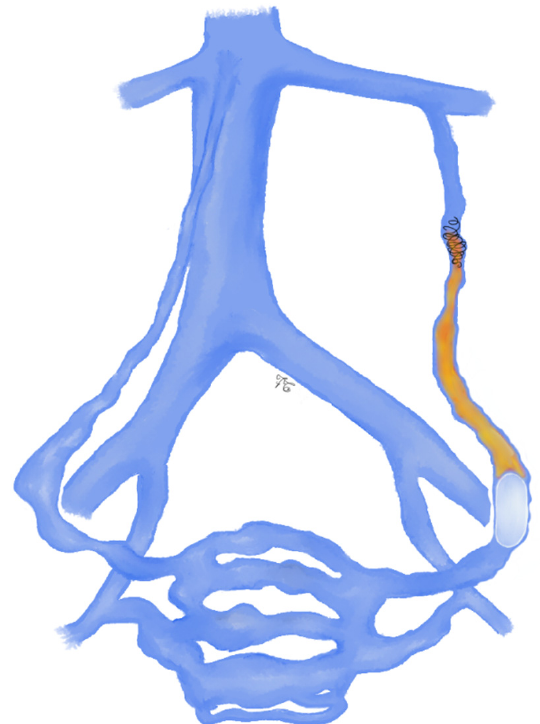
Figure 8. Drawing shows left ovarian vein embolization with sclerosing agent and coils: an occluding balloon is advanced to the lower third of the sacroiliac joint for the embolization of the gonadal vein; balloon insufflation was maintained for 5 min after the administration of sclerosant and the procedure was completed with the placement of metallic coils as reported by Meneses et al. [84]. It is difficult to establish whether unilateral embolization has a different result than a bilateral approach, as the studies and the opinions are heterogeneous and divergent [77];